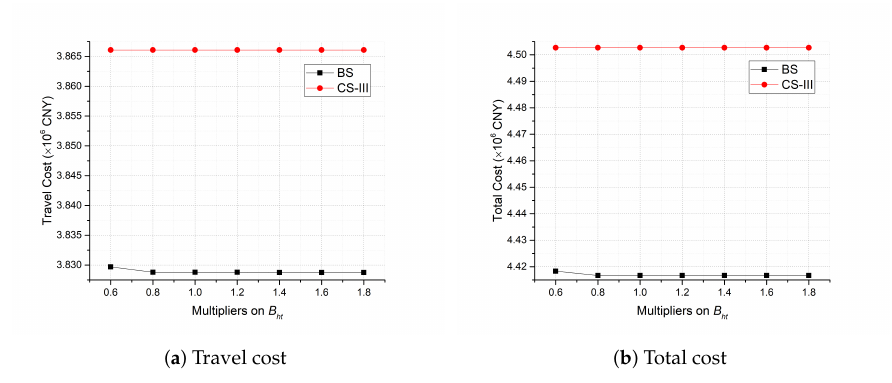
Figure 8. Sensitivity analysis on B ht